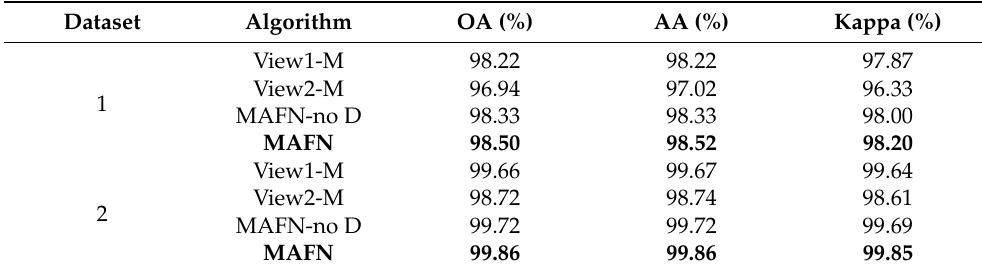
Table 4. Results of the strategies without decision-level fusion on the two